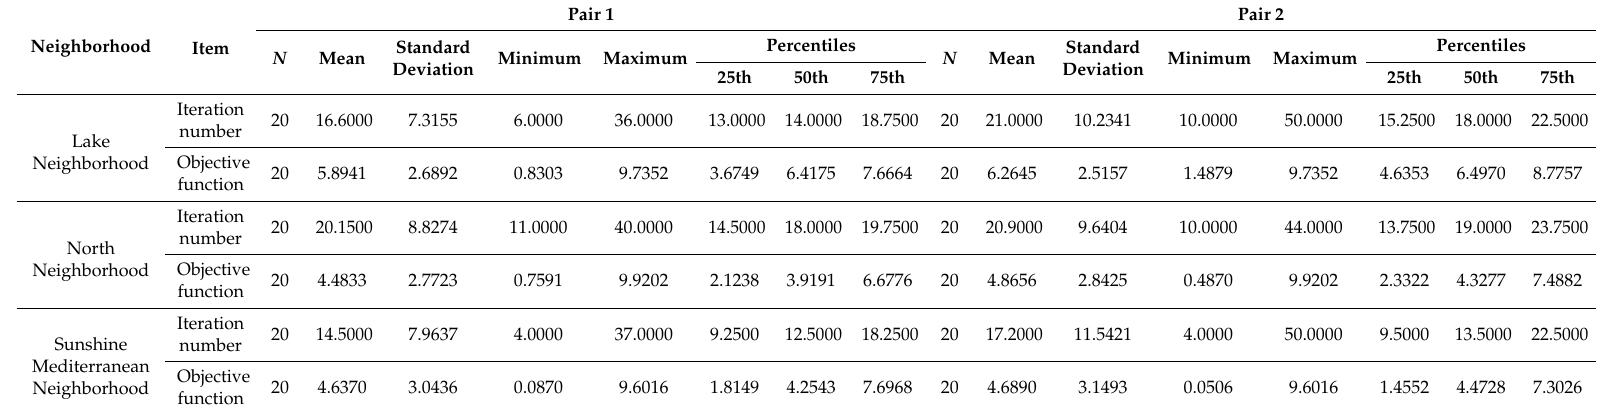
Table 2. Descriptive statistics of the two pairs.